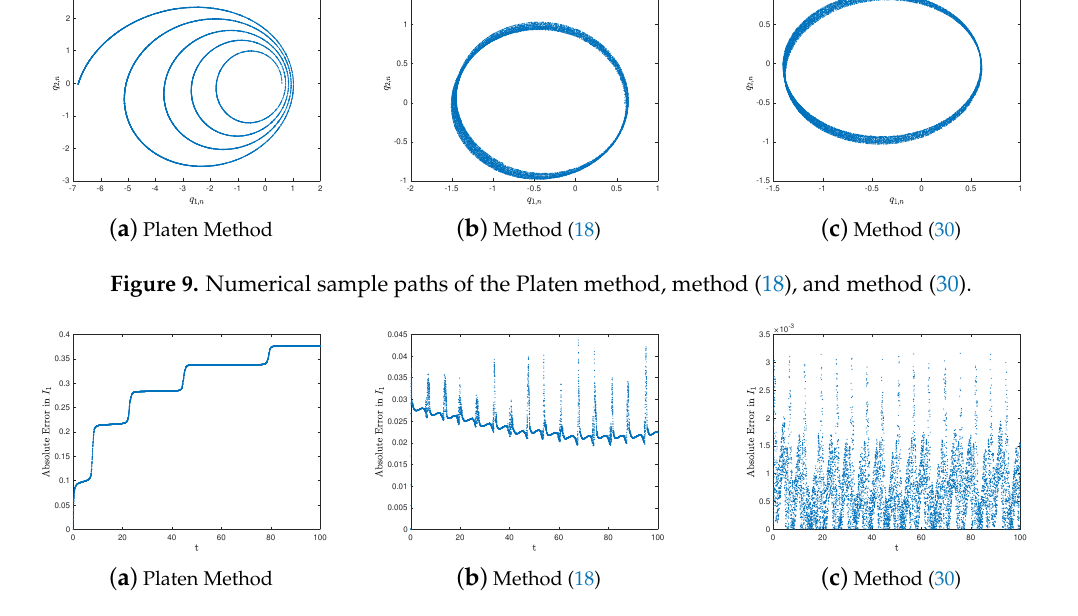
Figure 10. Conserved quantity errors in I 1 of the Platen method, method (18), and method (30).